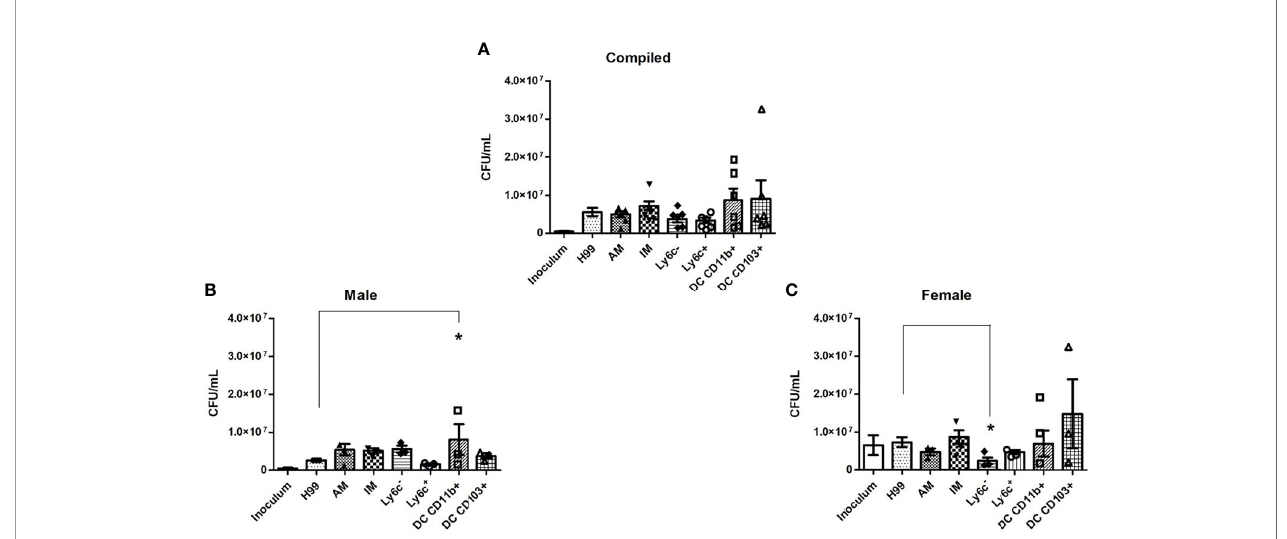
FIGURE 2 | Murine pulmonary phagocyte subsets exhibit differing anti-cryptococcal capabilities dependent upon sex. Pulmonary phagocyte subsets were puri fi ed from both male and female BALB/c mice and incubated with C. neoformans strain H99 for 24h at 37°C, 5% CO 2 at a ratio of 20:1. Macrophages or DCs were lysed with sterile water, then contents were diluted and plated on YPD agar. Plates were incubated for 48h at 30°C and CFUs were counted. (A) CFU counts from combined experiments from male and female phagocyte populations following C. neoformans strain H99 incubation alone (H99), with alveolar macrophages (AM), with interstitial macrophages (IM), with Ly6c - monocyte-like macrophages (Ly6c - ), Ly6c + monocyte-like macrophages (Ly6c + ), CD11b + DCs and CD103 + DCs. Inoculum indicates initial C. neoformans strain H99 concentration prior to incubation. (B) CFU counts from male phagocyte populations following incubation with C. neoformans strain H99. (C) CFU counts from female phagocyte populations following incubation with C. neoformans strain H99. The data are means ± standard errors of the means (SEM) for three independent experiments (n=3) each of both 20 male and 20 female mice (cells from 20 mice pooled for each experiment). Signi fi cant differences (*) shown represent p <